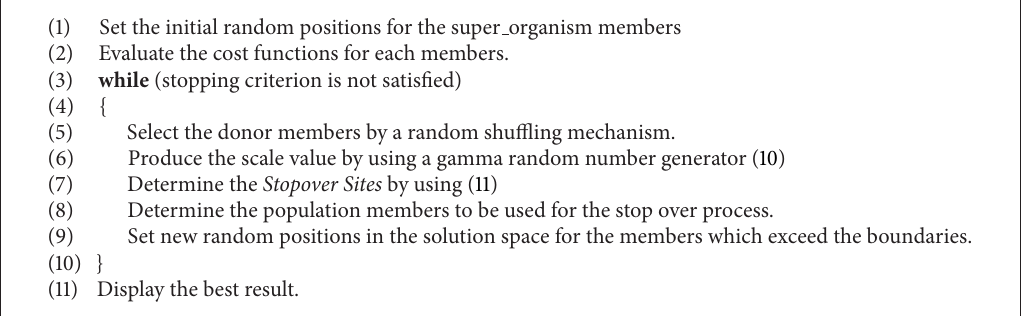
Algorithm 1: Pseudocode of DS